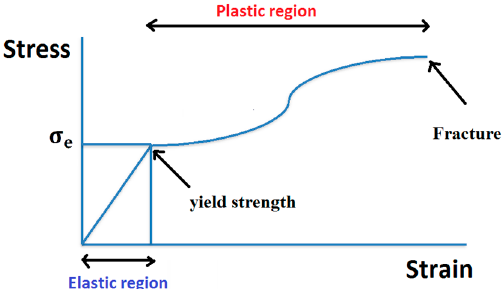
Figure 1. Elasto-plastic behavior of a metallic material.